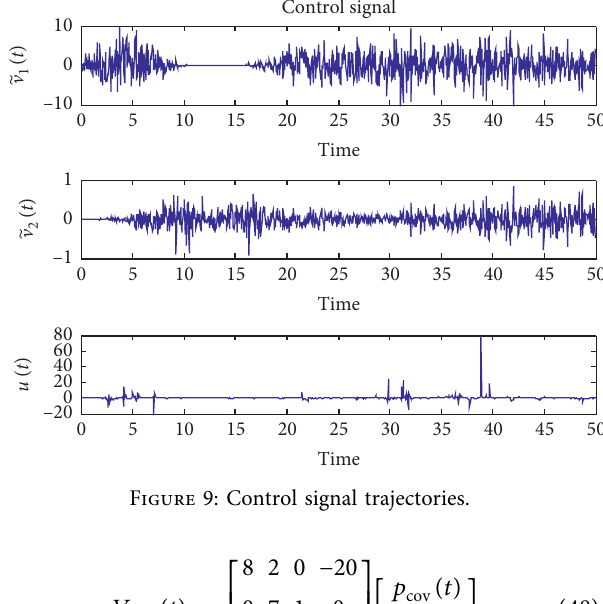
Figure 8: State variance and state trajectories of the system. Control signal